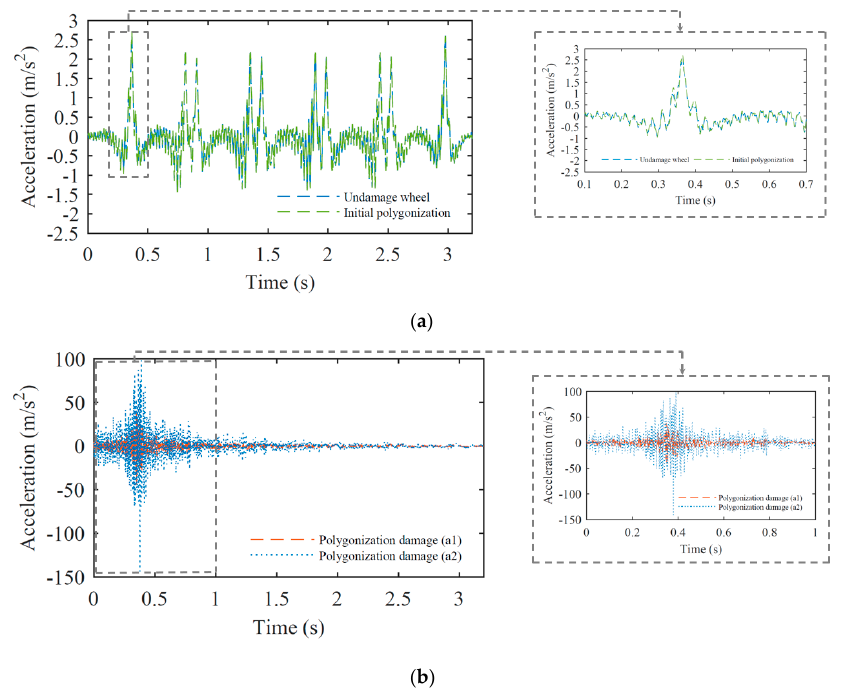
Figure 11. Acceleration time-series on position 1 for ( a ) healthy wheel and wheel with semi-imperfection profile, ( b ) damaged wheel.